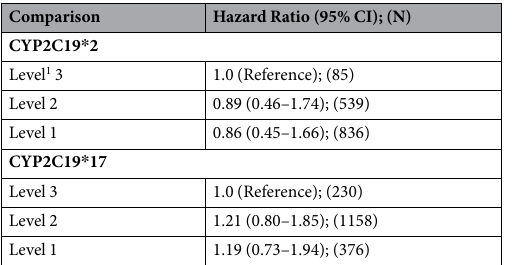
Table 4. Cox proportional hazard ratios for combinations of CYP2D6 metabolizer phenotypes with